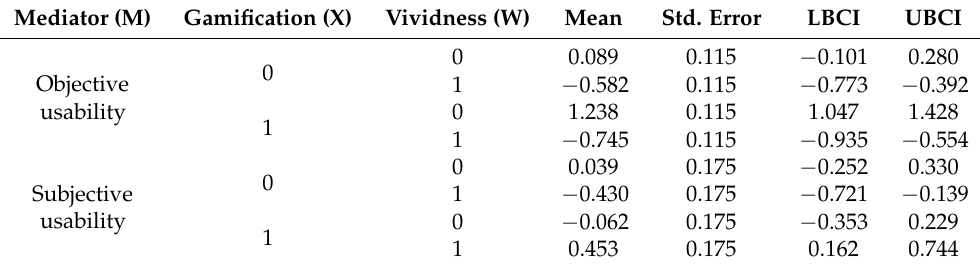
Table 15. Moderated mediation using a two-way analysis of variance (ANOVA) and the interaction relationships between gamification and vividness of in-person counseling.